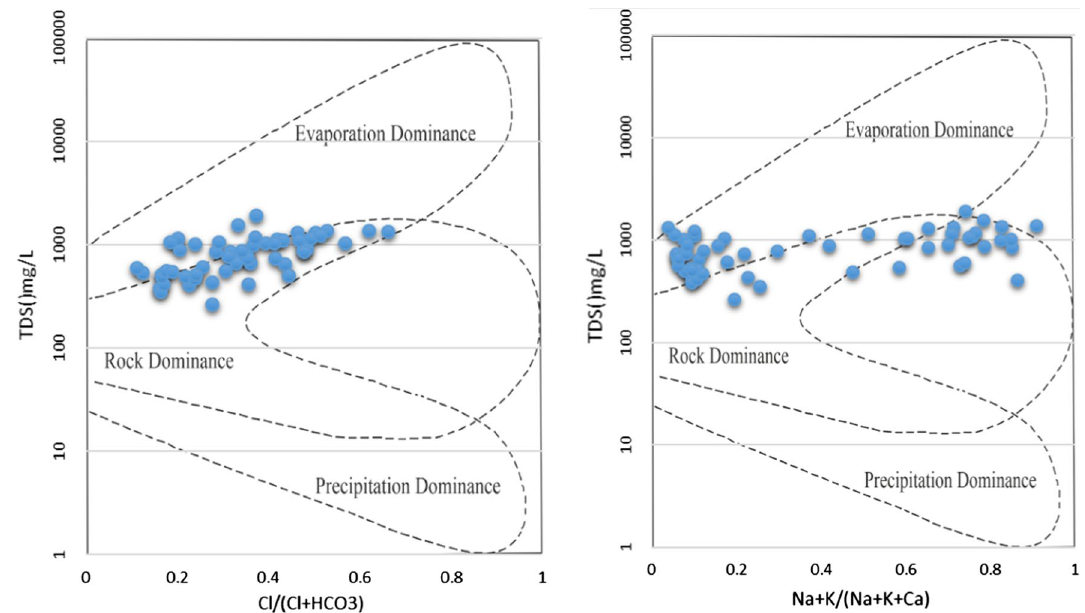
Fig. 3 Gibbs plot showing the groundwater of rock, precipitation and evaporation dominance